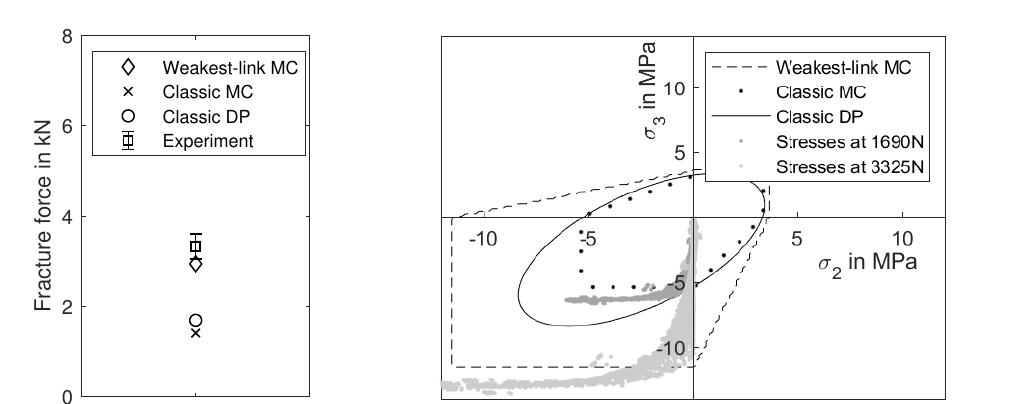
Figure 14. Stress field in the specimen of the Brazilian test. The stress components are calculated with FEM for a load force of 2kN. The course of fracture in the specimen reflects the stress peaks in these stress components.